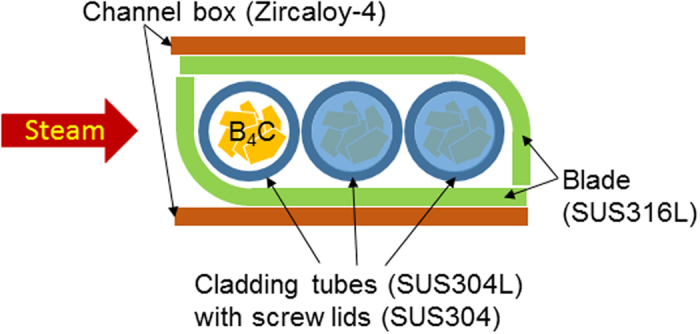
Schematic of the B4C control rod model used.